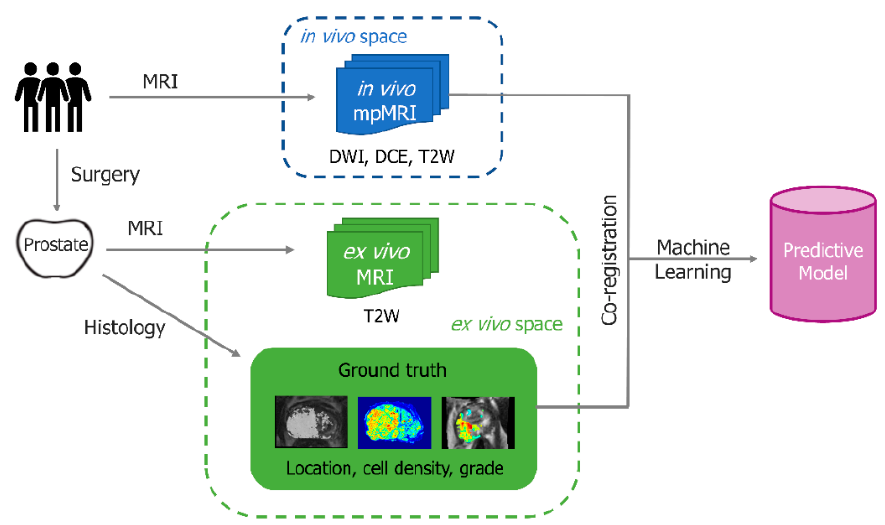
Figure 5. A diagram showing the predictive model development process for biofocused radiotherapy (BiRT). Prior to radical prostatectomy, in vivo multiparametric magnetic resonance imaging (mpMRI) data is collected. mpMRI feature extraction and selection is performed. Ground truth tumour biology maps are derived from removed prostate histology. Ground truth maps and mpMRI data are spatially registered using ex vivo and in vivo T2W images and machine learning methods are used to build predictive models. Regarding Figure 1, the resulting predictive models can be utilised to derive the tumour biology distribution from an individual patient’s multi-parametric images.